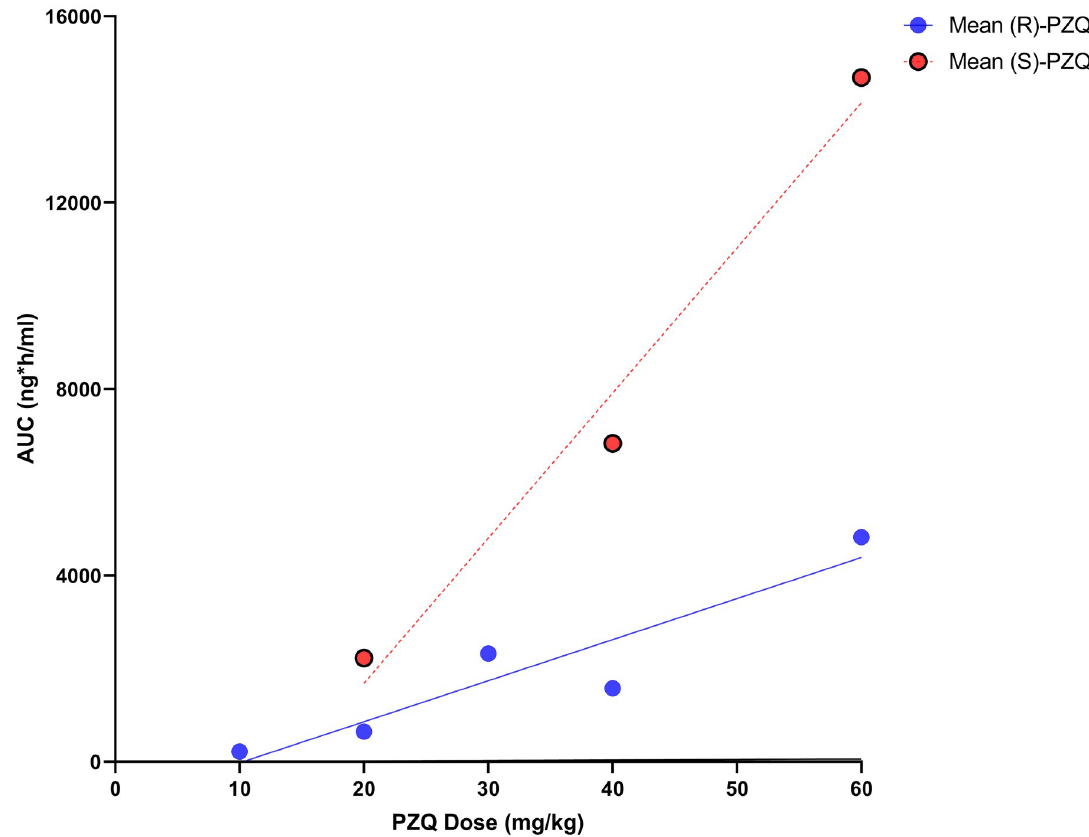
Fig 3. The mean AUC values extracted from the included studies against the PZQ dose of each of the PZQ enantiomers in HNV. The PZQ enantiomers were measured after a racemic PZQ dose or the (R)-PZQ dosed alone. These data were extracted from multiple papers in this review, separated by PZQ enantiomer, and the AUC was averaged for each dose and plotted on a graph for analysis [51– 54]. Using a linear regression model, the difference in AUC between (R)-PZQ and (S)-PZQ in humans was found to be statistically significant ( P < 0.05). AUC, area under the curve; HNV, healthy normal volunteers; PZQ,